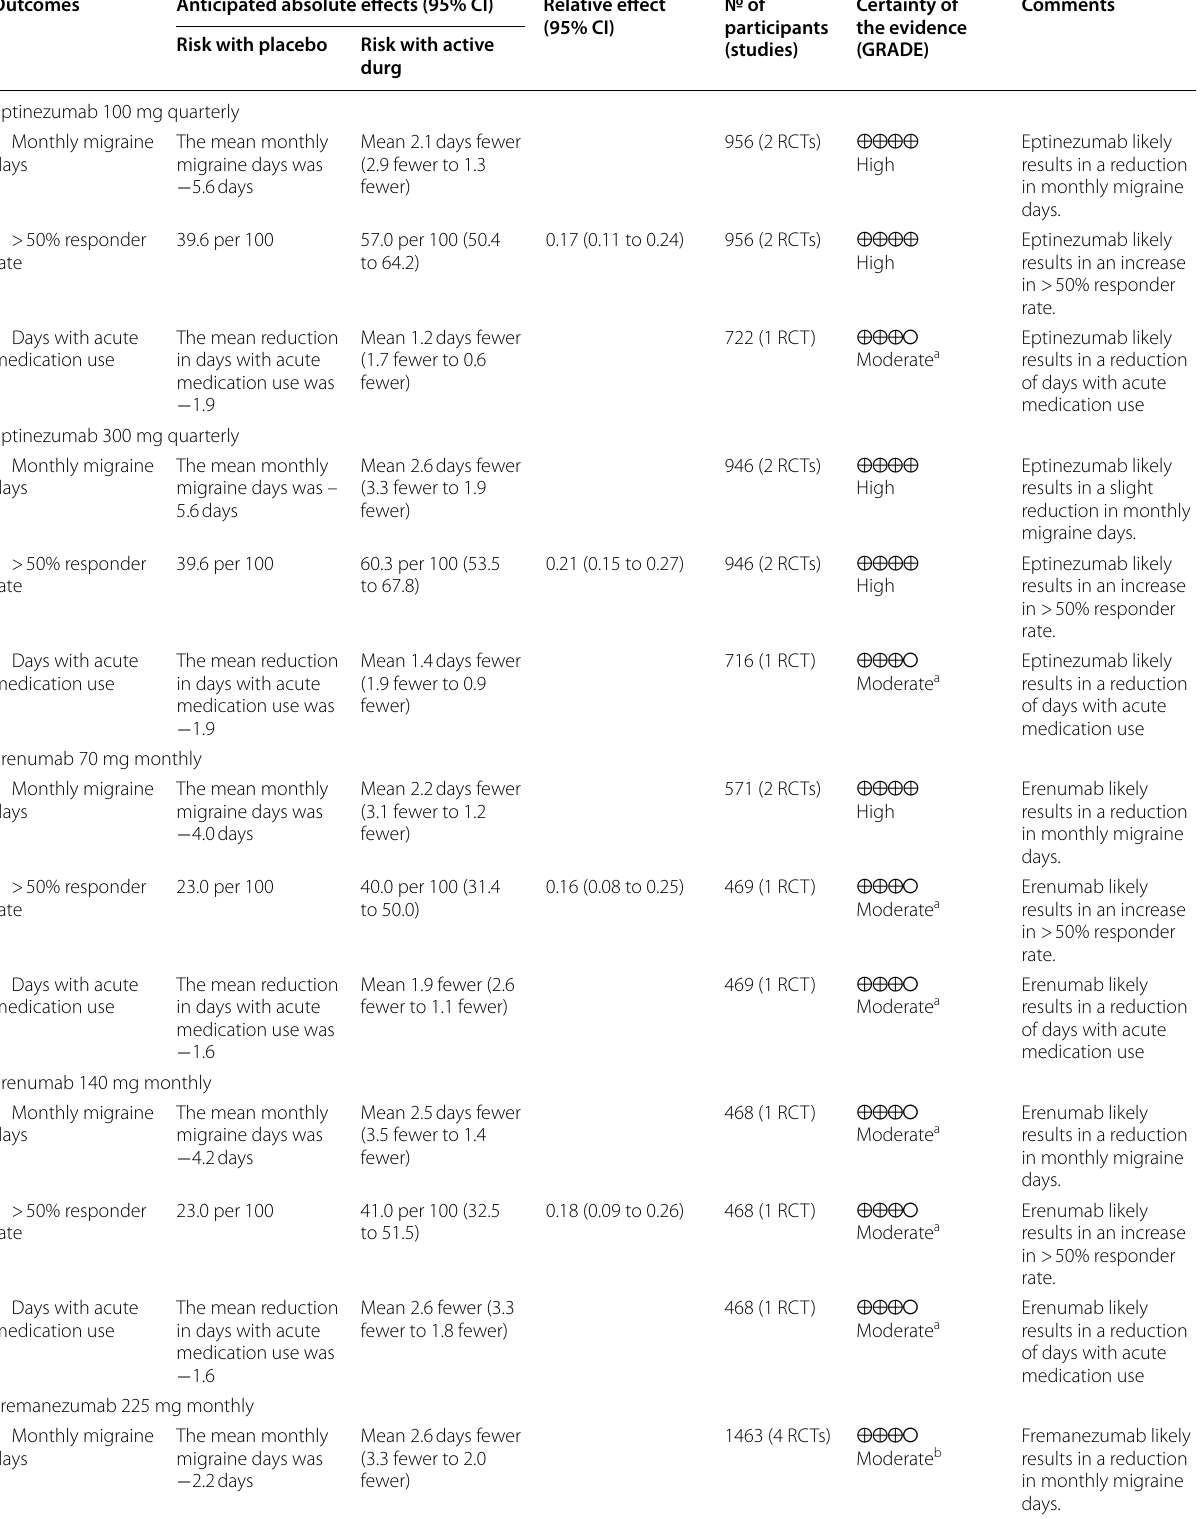
Table 6 Summary of findings for monoclonal antibodies targeting the CGRP pathway for the prevention of chronic migraine